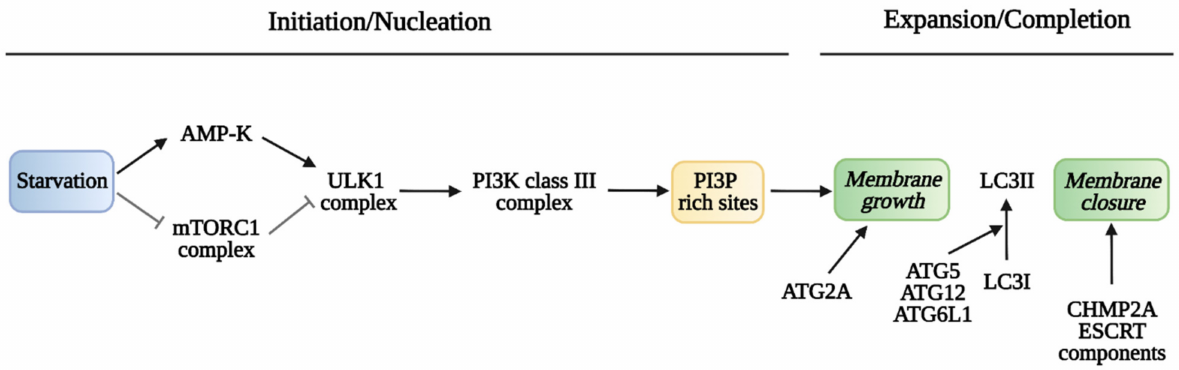
Figure 1. Overview of autophagosome formation. The main complexes involved in initia- tion/nucleation of the autophagosome membrane and in growth and closure of the autophagosome are reported. Image created with